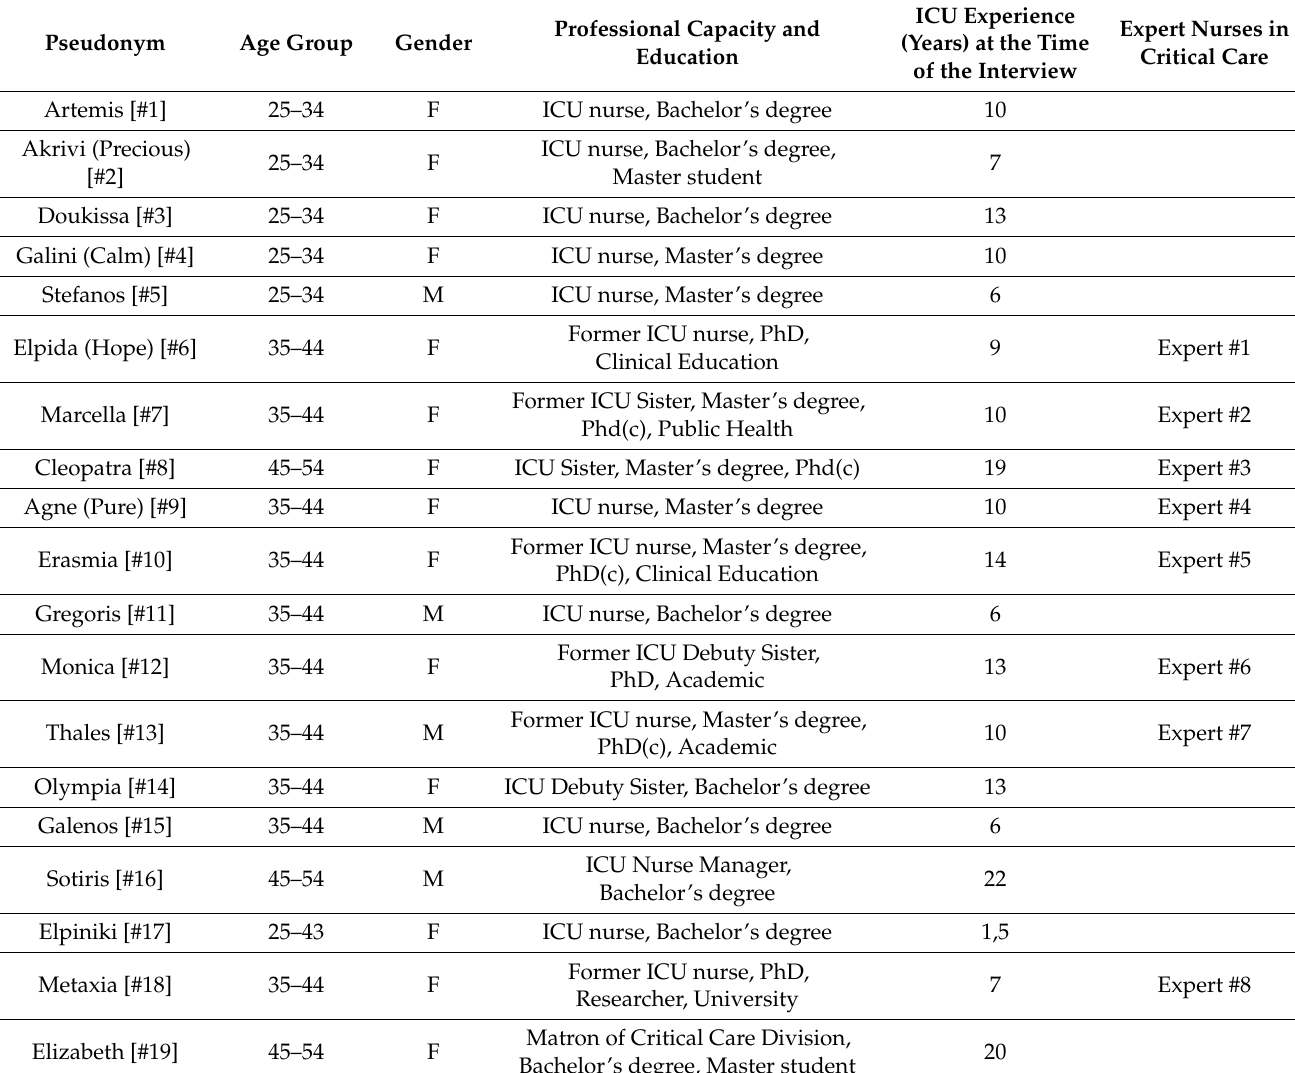
Table 1. Participant